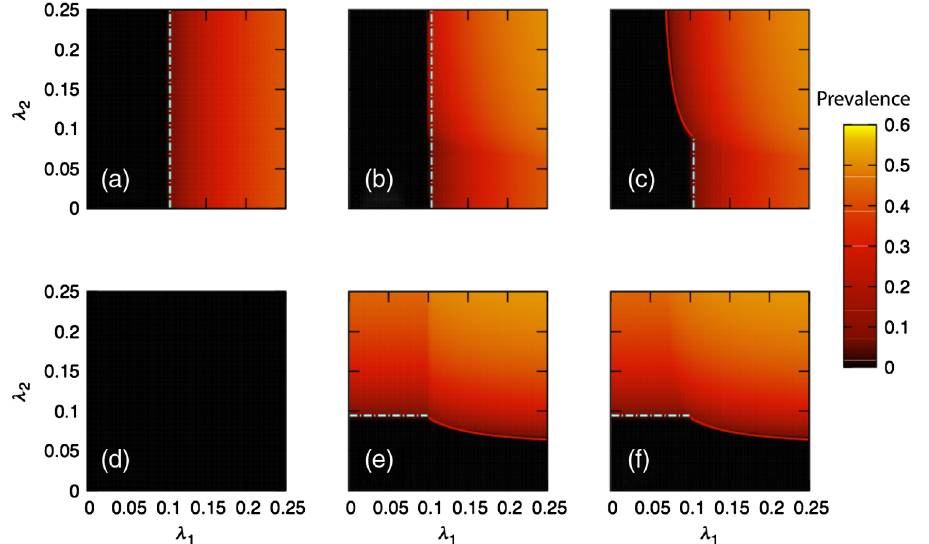
stage.FIG. 2. Reciprocally enhanced spreading. Dynamical parameters: μ 1 ¼ μ 2 ¼ 0 . 75 , β a 1 ¼ β b 1 ¼ β a 2 ¼ β b 2 ¼ 1 . 3 , η 1 ¼ η 2 ¼ 0 . 8